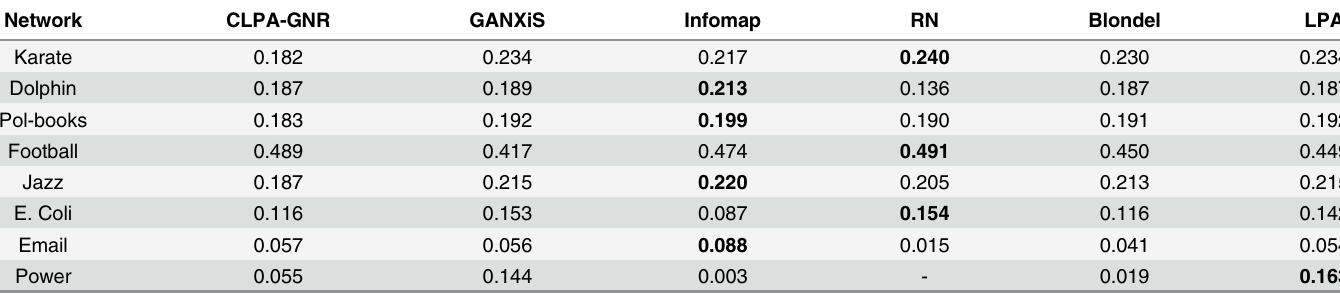
Table 8. The modularity density ( Q ds ) for all the real-world networks. Bold values are the best detection algorithm for each network. Network